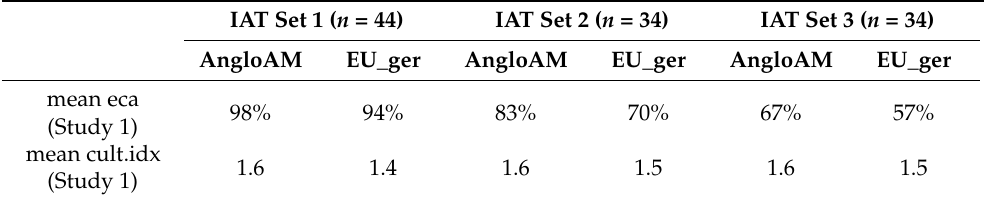
Table 7. Descriptive statistics from Study 1 according to the IAT sets. N: number of participants